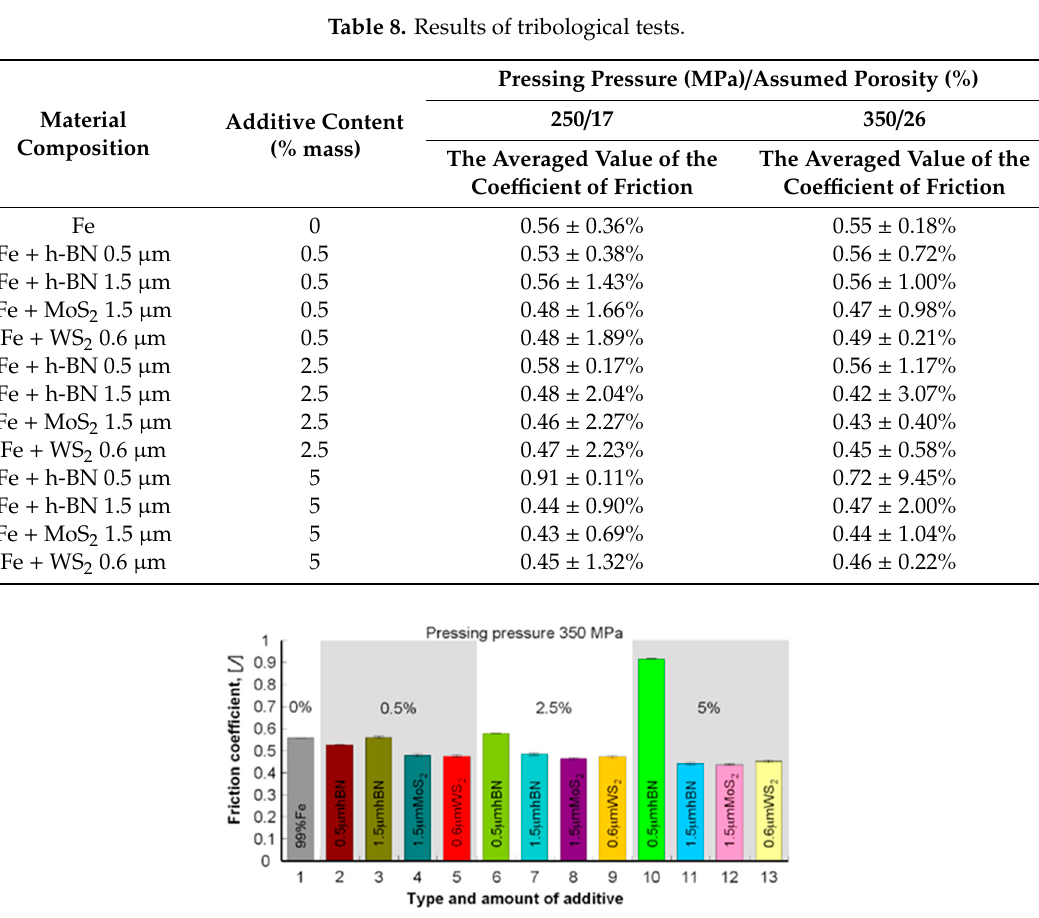
Figure 17. The coefficient of friction depending on the amount and type of layered additive in the samples pressed under the pressure of 350 MPa.